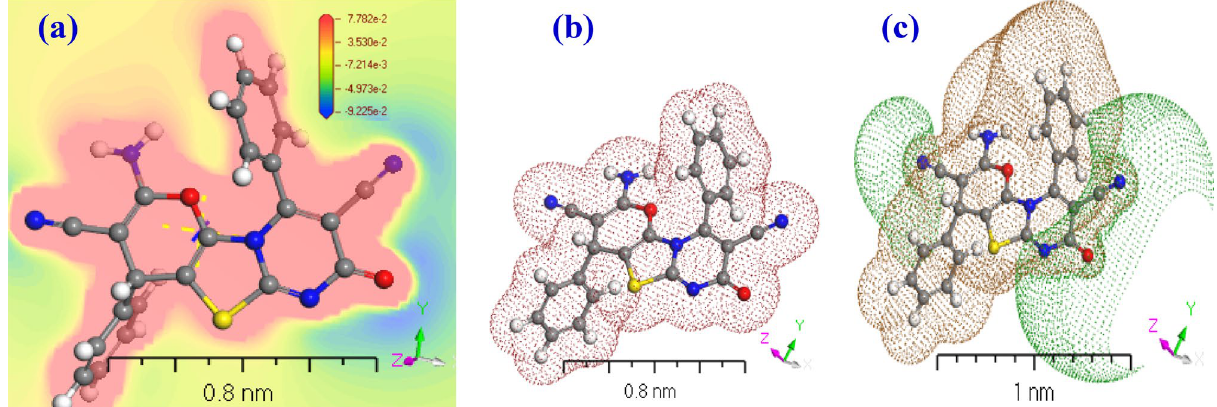
Figure 4. TD-DFT computation of ( a ) MEP of the [ThiPy-3,8-Dc] Iso , ( b ) Electron density and ( c ) Potentials of [ThiPy-3,8-Dc] Iso using the DMOl 3